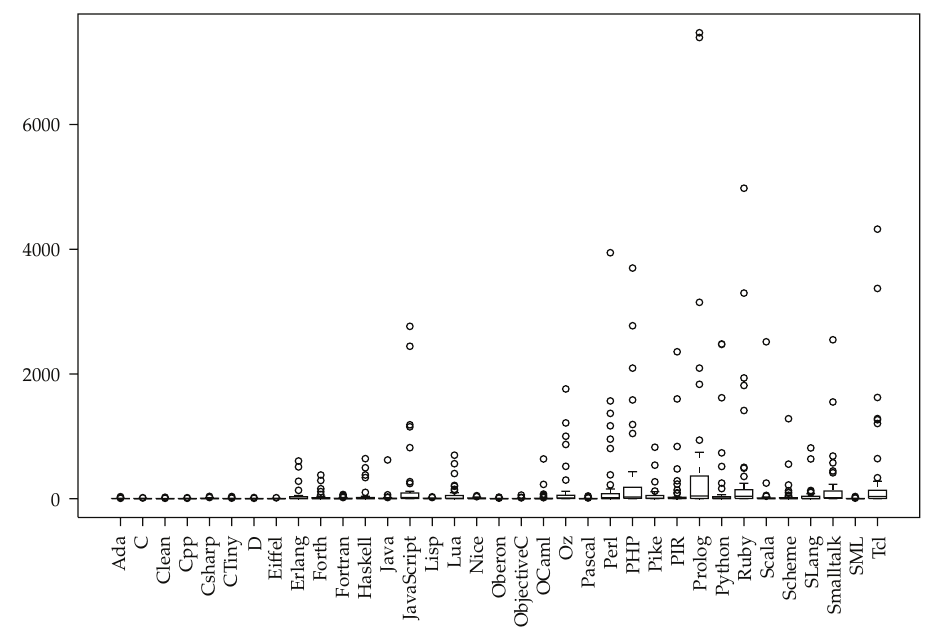
Figure 1: Distribution of the values of CPU time recorded for each language.